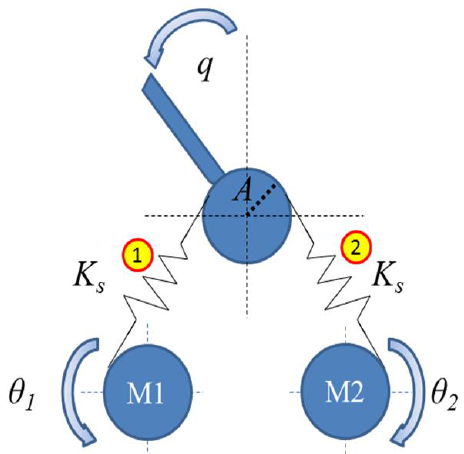
Figure 2. Simple antagonistic class of a stiffness adjustment mechanism.